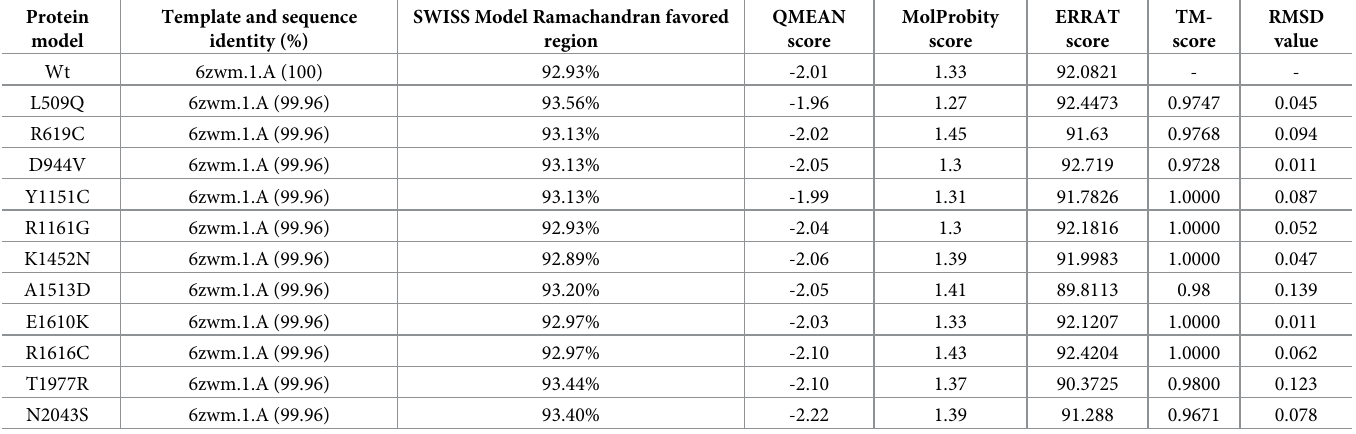
Table 5. Structure validation of the 3D protein models of mTOR protein and TM-score and RMSD values of mutated mTOR and wild-type mTOR. Protein Template and sequence model identity